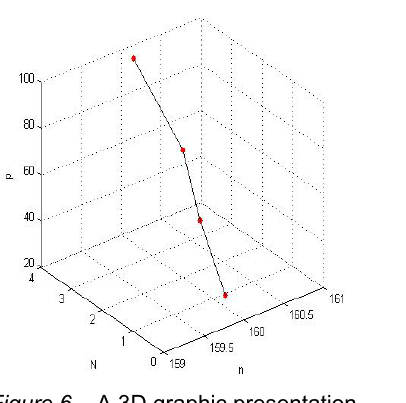
Figure 5 – A 3D graphic presentation for the password length of n = 128 bits Рис . 5 – 3 Д графическое изображение пароля размером n = 128 битов Слика 5 – 3 Д графичка презентација за лозинку дужине n = 128 bits